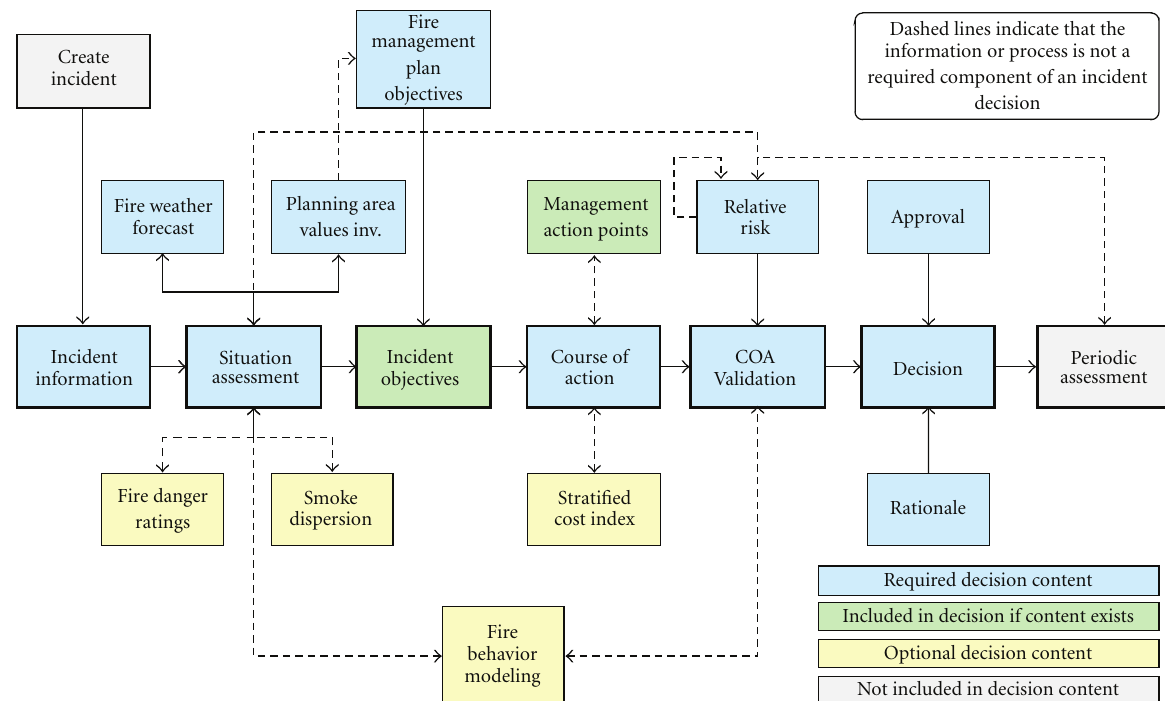
Figure 2: WFDSS conceptual model. The highlighted bolded horizontal flow depicts the major phases necessary to make a decision in